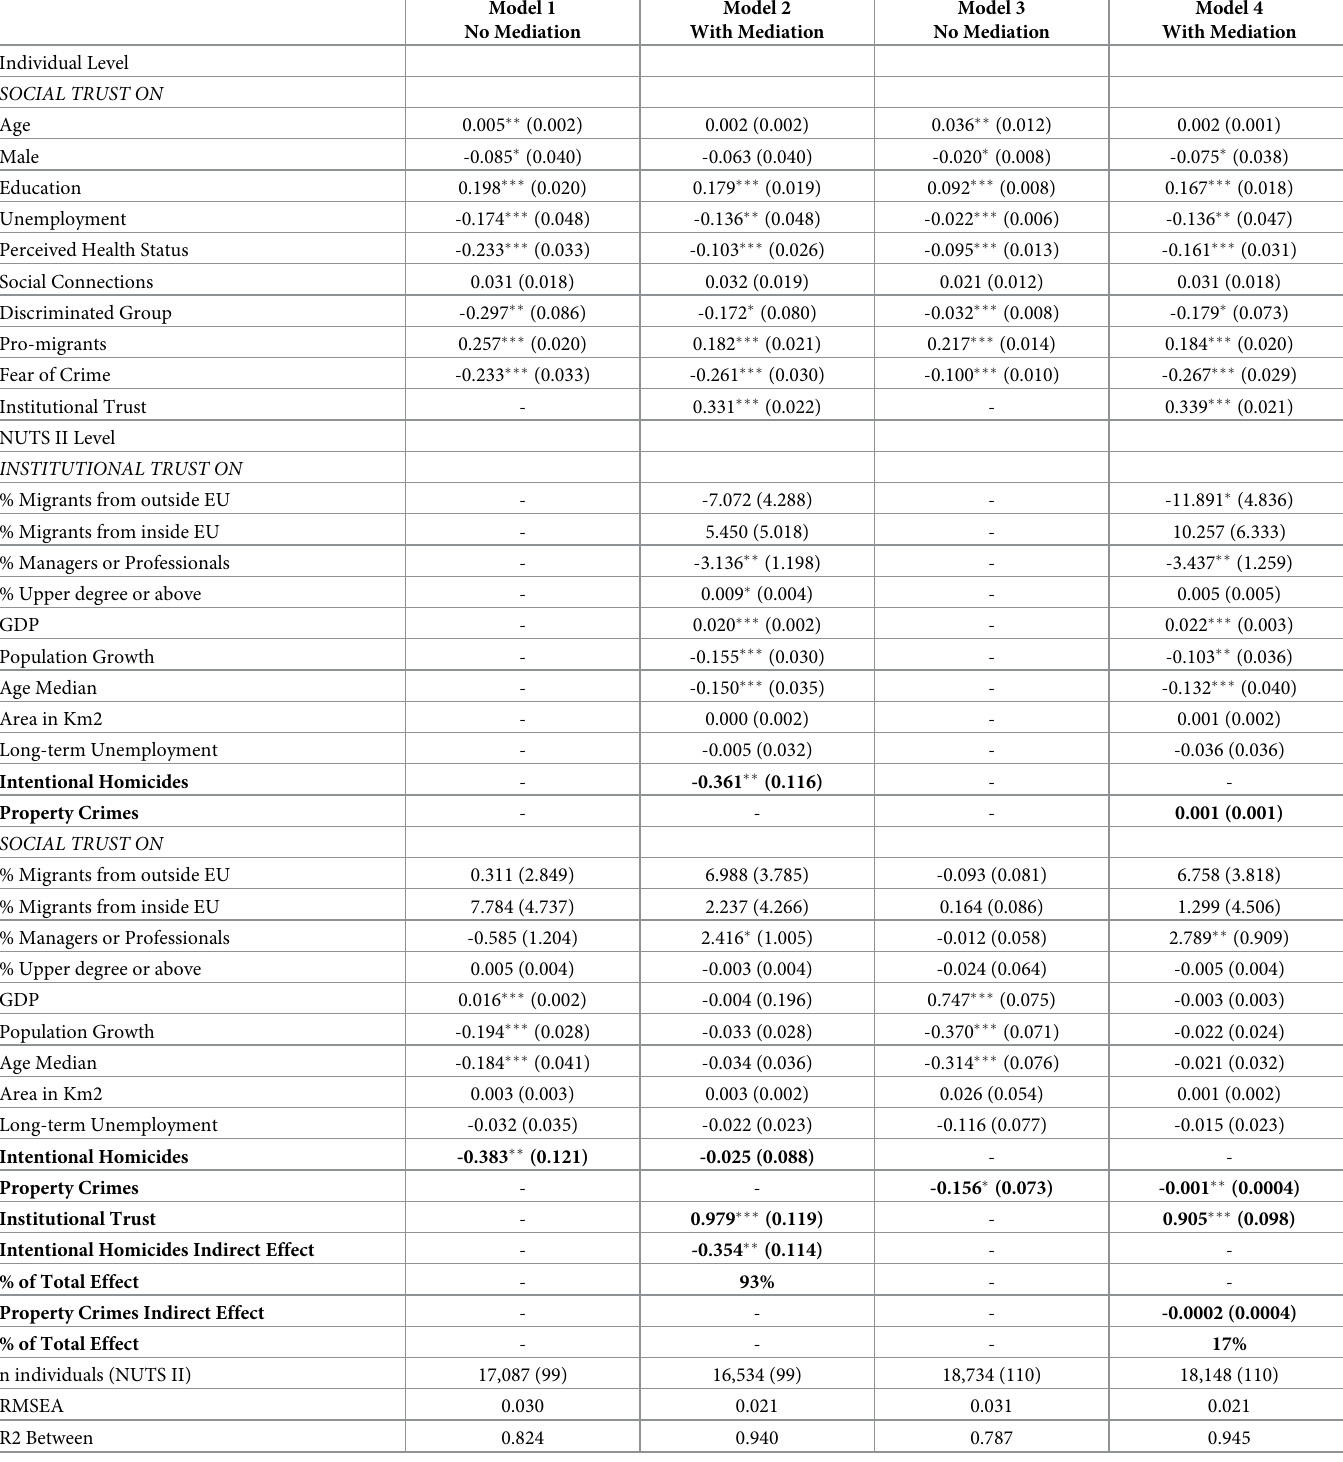
Table 3. MSEM testing the mediation effect of institutional trust on the relationship between crime and social